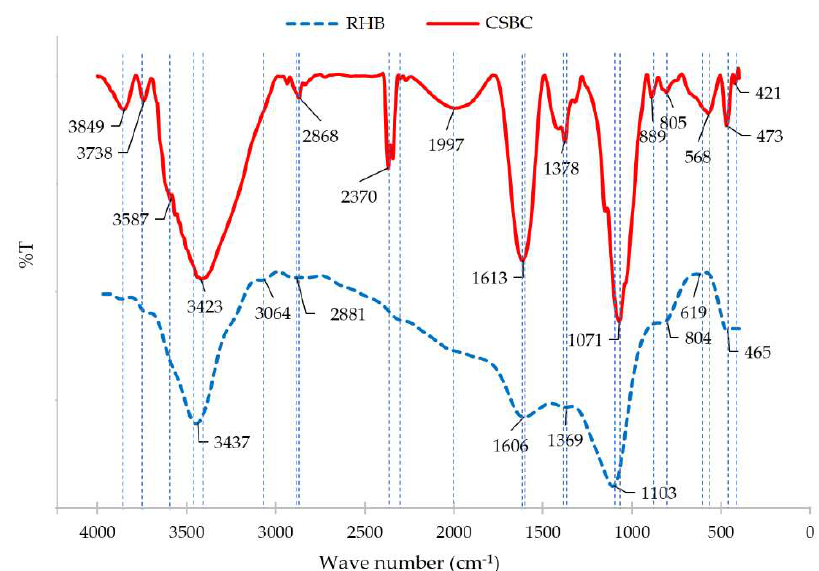
Figure 3. The FTIR analysis of RHB and CSBC.